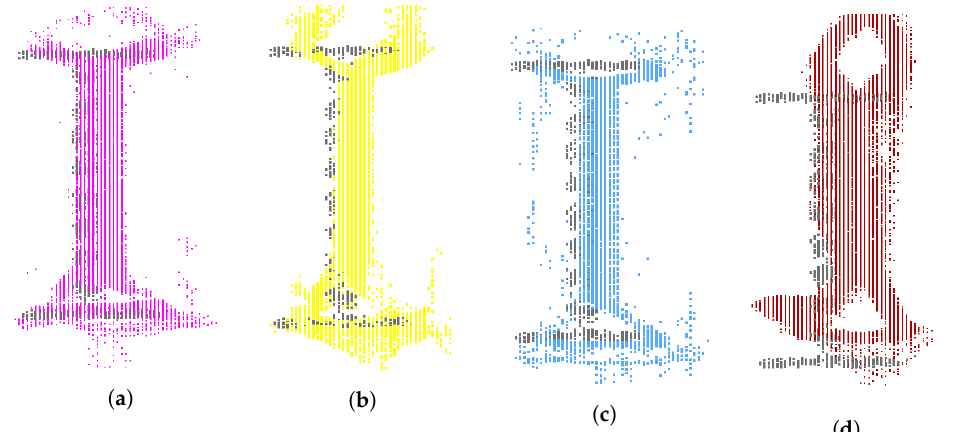
Figure 13. Detailing shortcomings: Modeling detailed beam profiles from the Hololens 2 data is impossible due to the noise and the reduced resolution. From the data of the high-end devices, the I-profile can be identified. However, the thickness of the body of the profile remains challenging to model due to noise. ( a ) VLX, ( b ) M6, ( c ) P30, and ( d ) Hololens